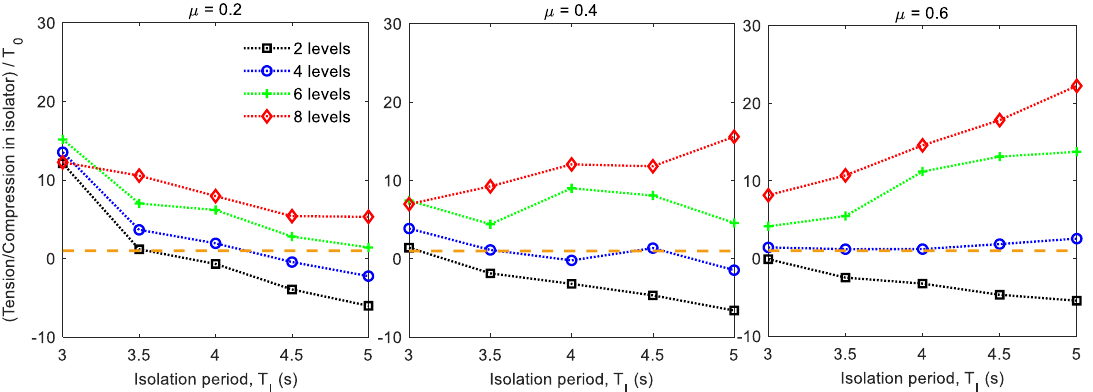
Figure 16. Ratio between the maximum axial load (traction > 0) or minimum axial load (compression < 0) on the isolator and the initial tension of the elastic element inside the insulator ( T 0 ). Orange segmented line (value 1) delimits the occurrence of the survey (points above said line). The seismic action is acting in cross the aisles direction of the rack.